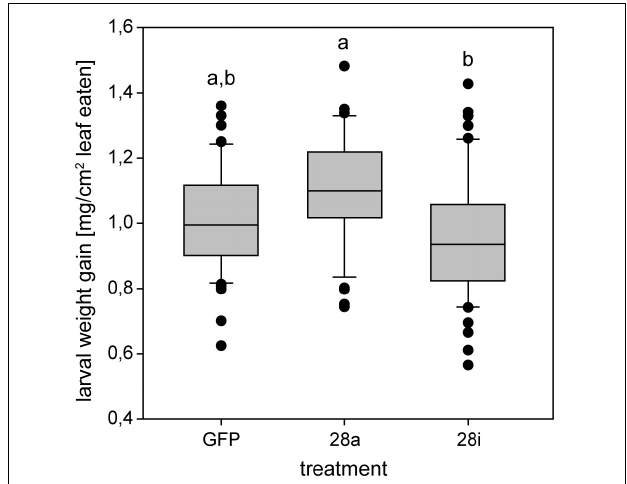
FIGURE 4 | Efficiency of food-to-energy conversion from early second- to third-instar P . cochleariae larvae. Injection control (GFP) and the two silencing treatments are compared and the efficiency is calculated as mg larval weight gain per cm 2 leaf eaten over